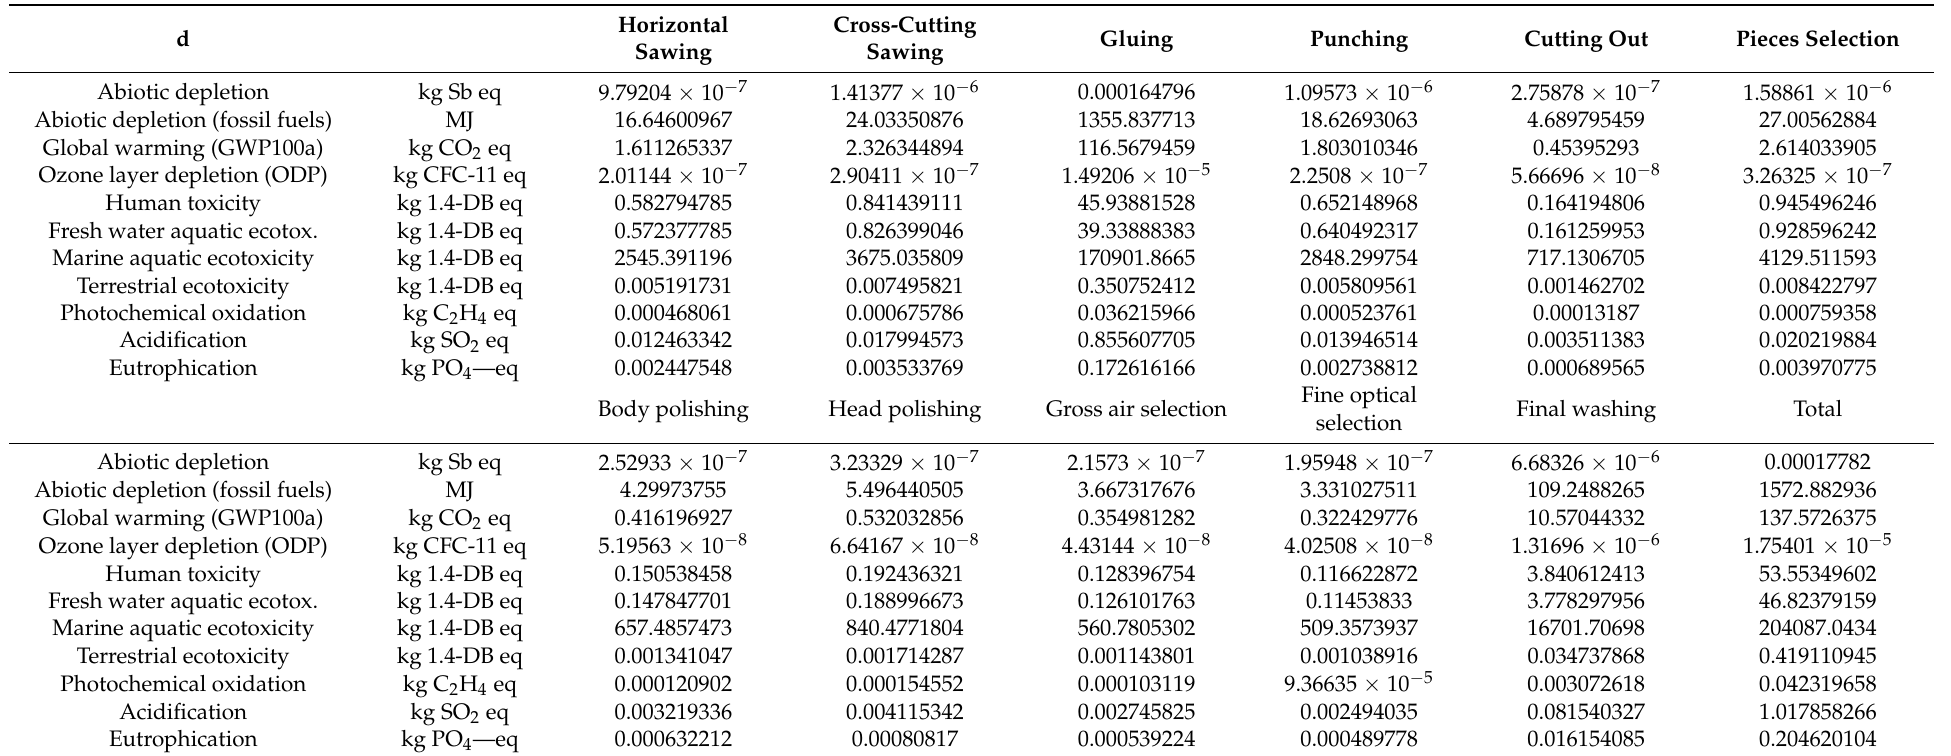
Table 10. Impact of stage 2 broken down by activities for the manufacturing process of two-piece perforated caps of 24 mm diameter and 44 mm in length. d